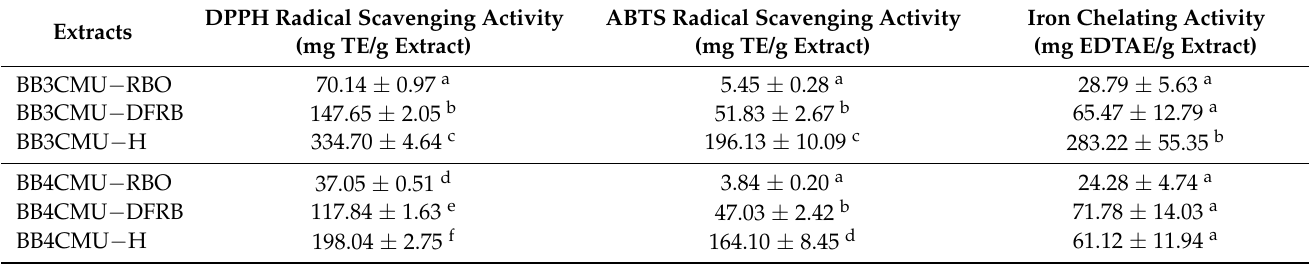
Table 1. Antioxidant potential of Oryza sativa L. cv. BB3CMU and BB4CMU